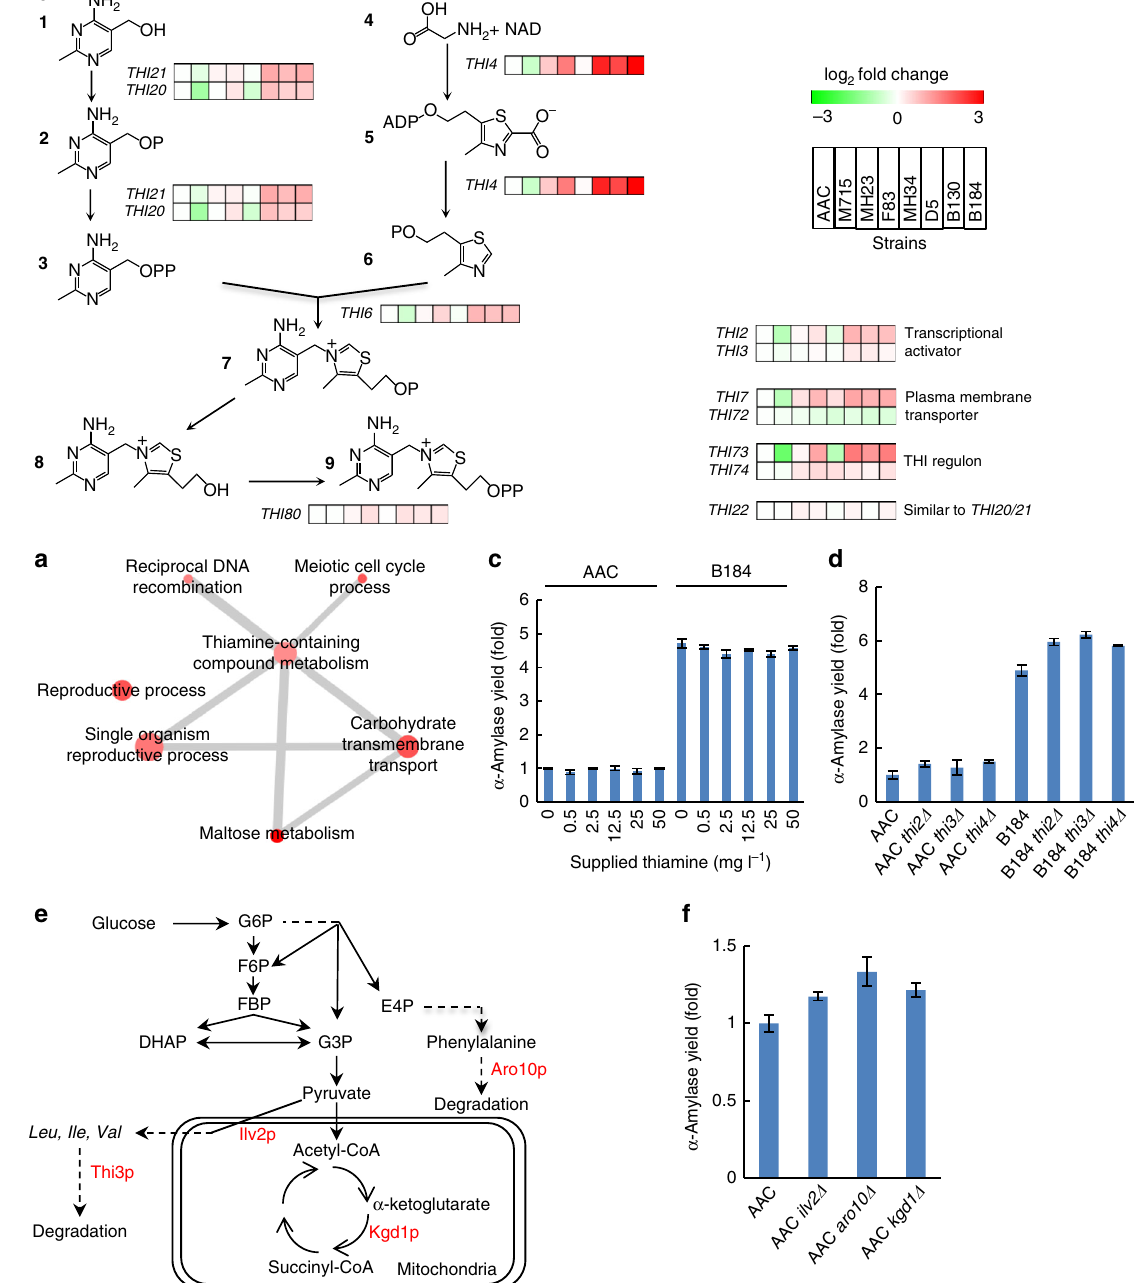
Fig. 5 Low thiamine status is favorable for α -amylase production. a GO bioprocess enrichment of most upregulation genes ( P -adj < 0.05 (Benjamini – Hochberg method) and log 2 fold change > 0.5) in strain B184. b Transcriptional levels of genes related to thiamine biosynthesis. 1: hydroxymethylpyrimidine; 2: hydroxymethylpyrimidine phosphate; 3: 2-methyl-4-amino-5-hydroxymethylpyrimidine diphosphate; 4: L -glycine; 5: adenylated thiazole; 6: 4-methyl-5-( β -hydroxyethyl)thiazole phosphate; 7: thiamine phosphate; 8: thiamine; 9: thiamine diphosphate. c α -Amylase production in the SD-2 × SCAA medium supplied with different amount of thiamine. d Deletion of THI2 , THI3 , and THI4 enhances α -amylase production. e Thiamine diphosphate-dependent enzymes involved in amino-acid metabolism. DHAP dihydroxyacetone phosphate; E4P erythrose-4-phosphate; F6P, fructose-6-phosphate; FBP, fructose-1,6-bisphosphate; G6P, glucose-6-phosphate; G3P, glyceraldehyde-3-phosphate. f Deletion of ILV2 , ARO10 , and KGD1 enhances α -amylase production. Data shown in c , d , f are mean values ± standard deviations of